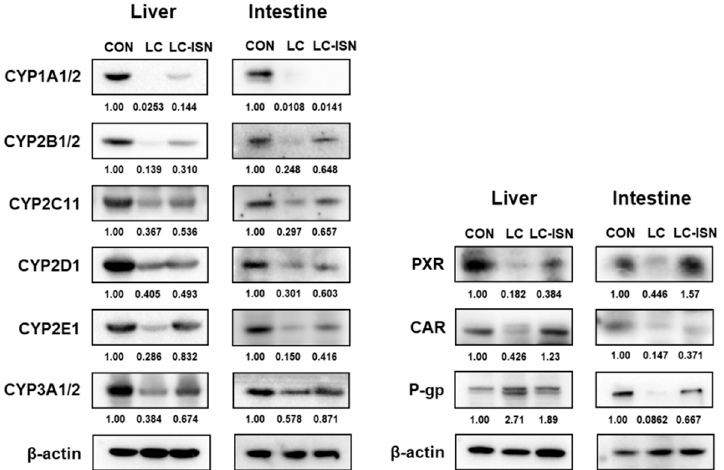
Figure 6. Immunoblot analyses of CYP isozymes, PXR, CAR and P-gp in the hepatic and intestinal microsomes obtained from CON, LC and LC-ISN rats. ß-actin was used for the loading control. This experiment was repeated thrice. Band density was determined by ImageJ 1.45s software (NIH). CON, control; LC, liver cirrhosis induced by N -dimethylnitrosamine; LC-ISN, LC with treatment of isosakuranetin; CYP, cytochrome P450; PXR, pregnane X receptor; CAR, constitutive androstane receptor; P-gp, P-glycoprotein.